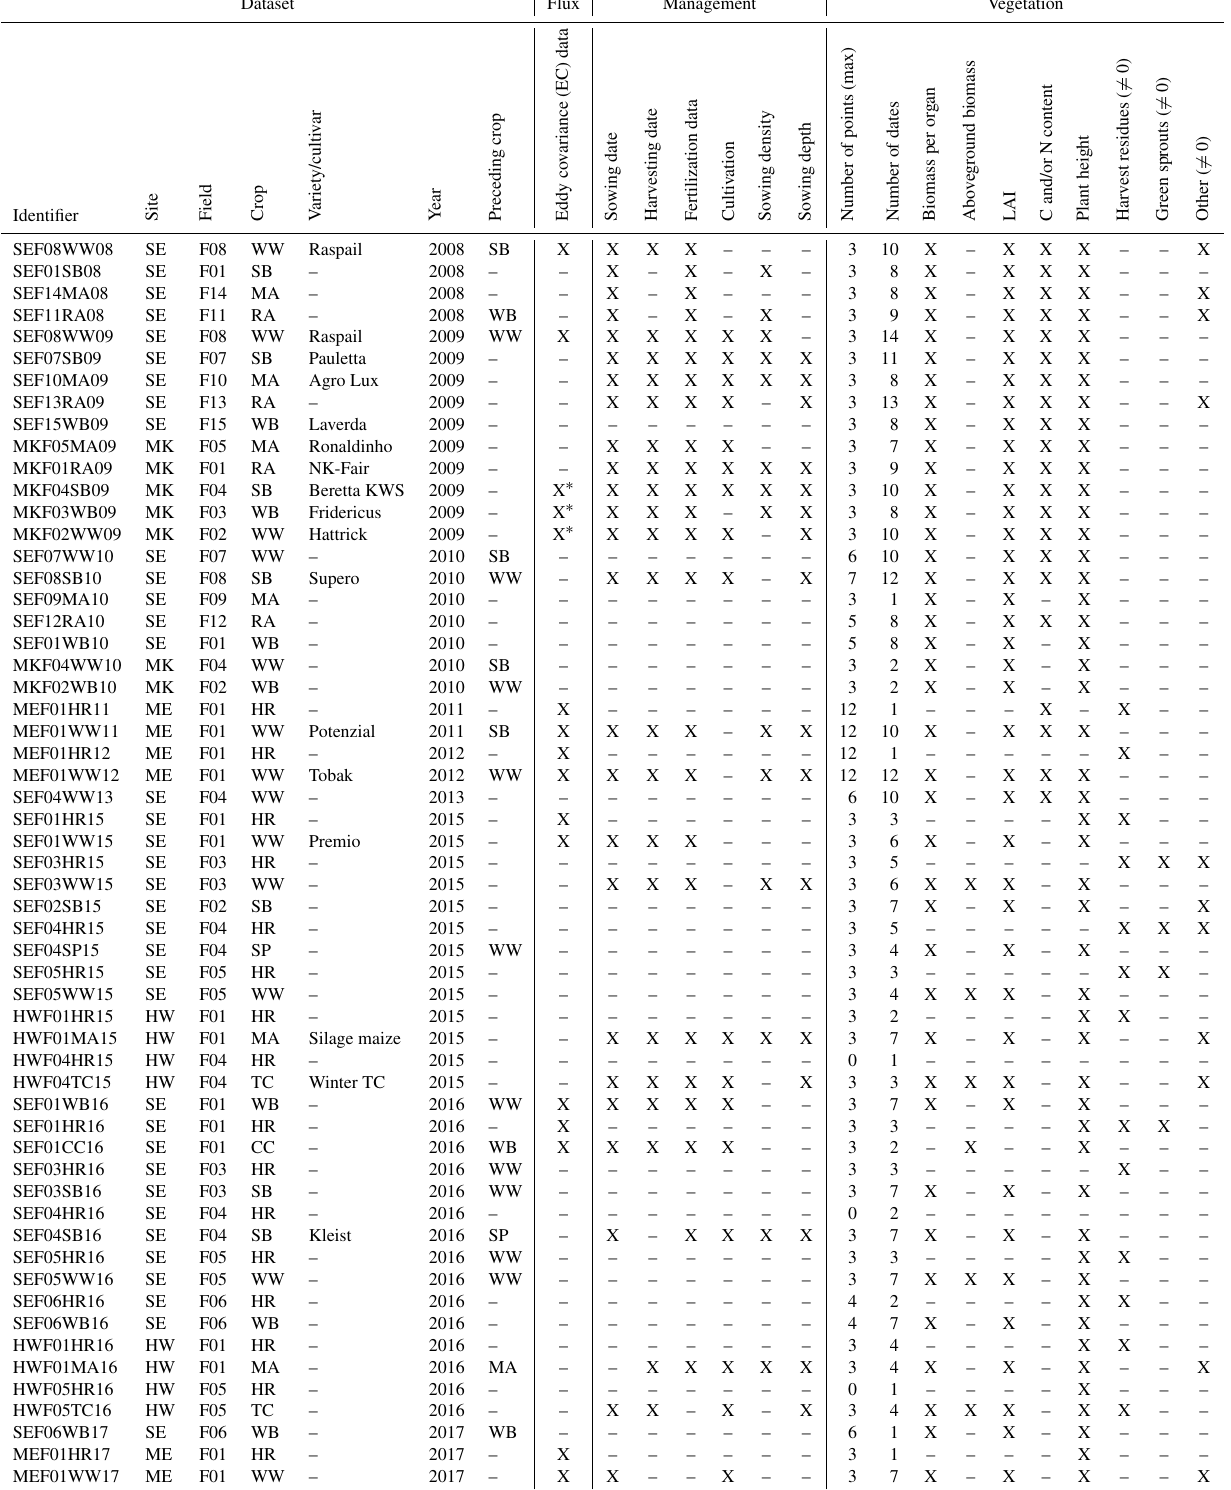
Table 3. Data availability for vegetation data, fluxes, and management data (“X” data available, “–” no data available). For an explanation of vegetation data categories, refer to Sect. 4. For crops, the year refers to harvest. Concerning vegetation data, the number of points gives the maximum number of points in the field measured on the same date. In the event of harvest residues, green sprouts, and other biomass, data are only marked available if at least one value unequal to zero is